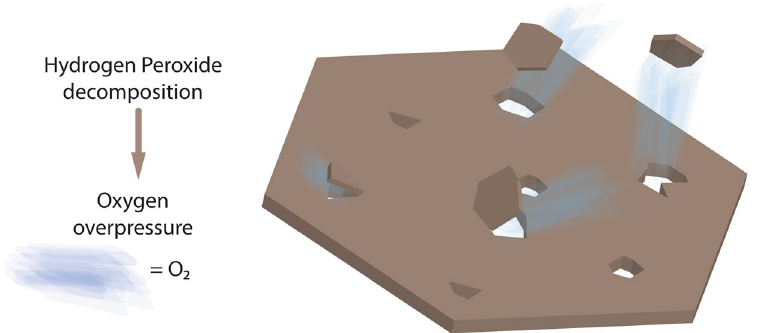
Figure 6. Schematic representation of the micropore formation process in Mg-Al LDH as proposed in this microporous openings of the interlayer region. On the other hand, all three treatments with H 2 O 2 led to a notable increase of the final specific surface area. LDH-I-H 2 O 2 shows a relative increase of specific surface area by 300%, mostly due to the increase of meso/macroporous surface area. This cannot be attributed to the formation of new pores as evidenced in Fig. 5c, but to (local) interlayer distance enlargement and turbostratic rearrangement of